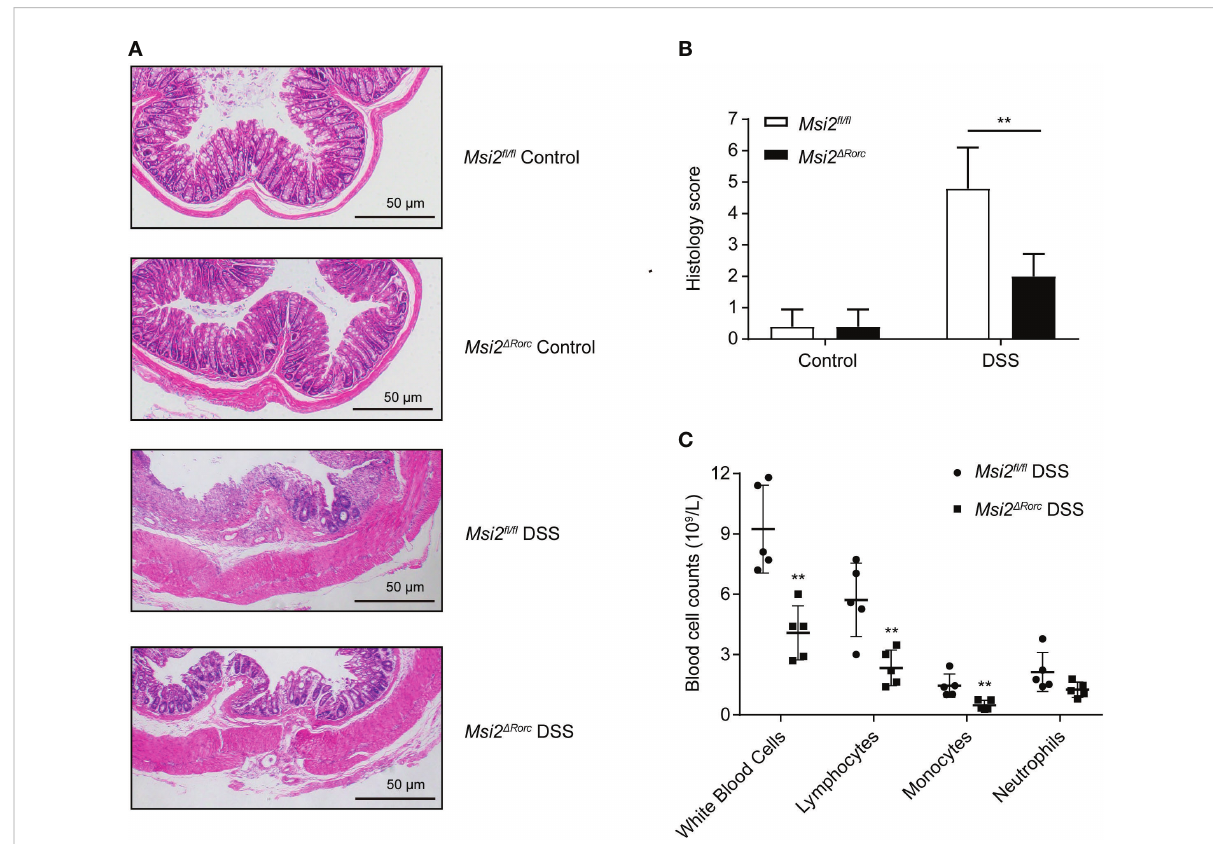
FIGURE 3 Both histopathological lesions and peripheral blood leukocytes were reduced in the Msi2 D Rorc mouse model. (A, B) Msi2 fl / fl and Msi2 D Rorc mice were fed 4% DSS or water ad libitum for 5 days, which was followed by recovery on regular drinking water for 2 days prior to euthanasia. Representative images of HE-stained sections of colons (original magni fi cation ×100) from Msi2 fl / fl and Msi2 D Rorc mice on day 8 and careful examination of the colonic histopathological score. (C) The white blood cell counts of both the Msi2 fl / fl DSS group and the Msi2 D Rorc DSS group were evaluated and identi fi ed using an automatic blood cell analyzer BM830 on day 8. Data represent the means ± SEMs (n=5). **p <